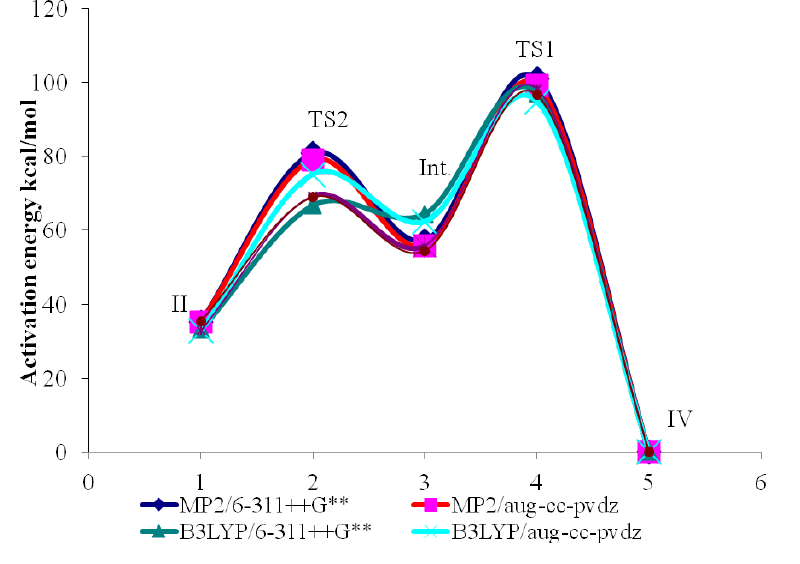
Figure 3 . Schematic potential energy profile showing the activation energies (kcal/mol) for the tautomerization of II and IV, which were calculated by using the elected levels of